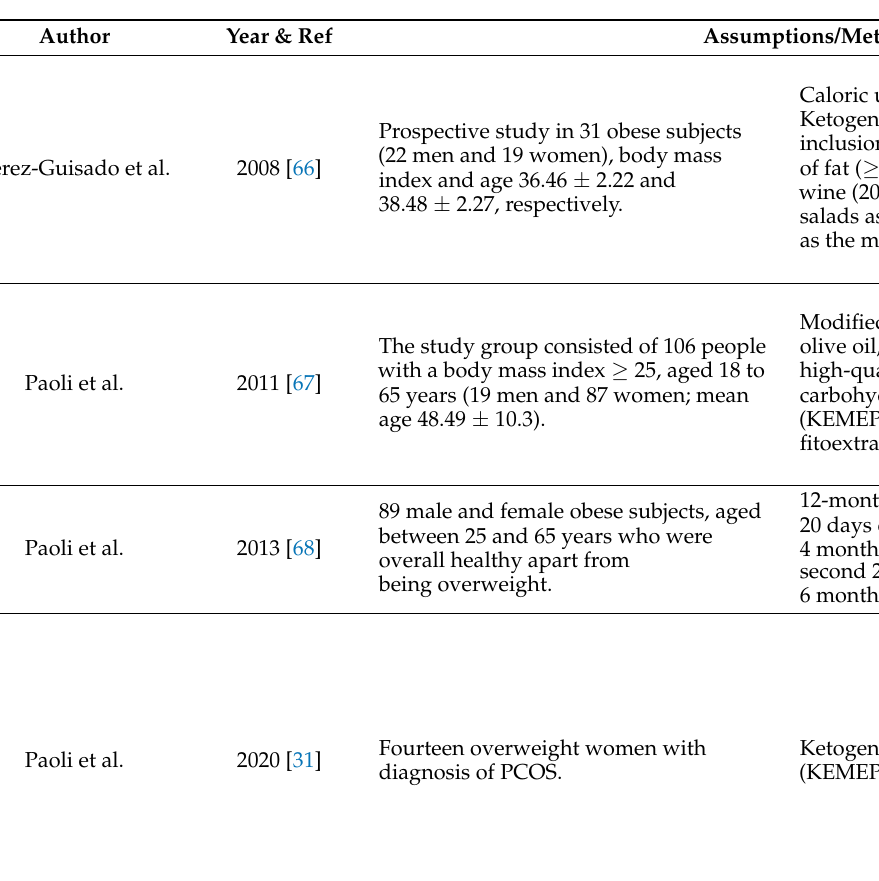
Table 5. Effects of KEMEPHY